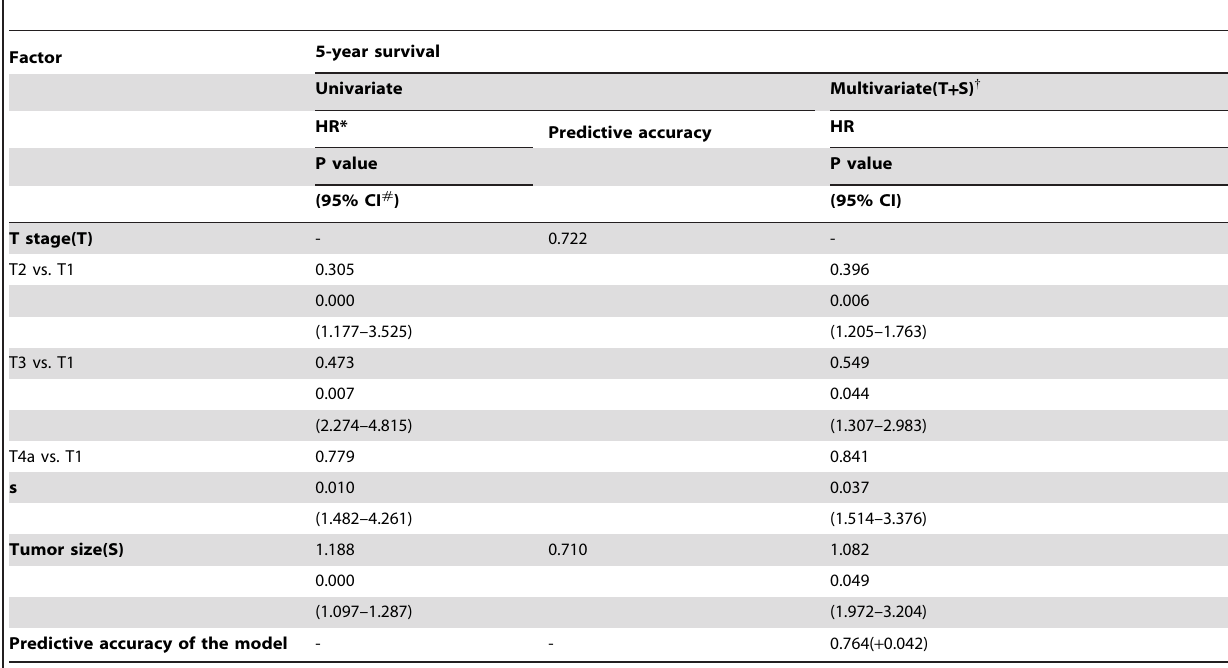
Table 3. Univariate and multivariate Cox regression models predicting depth of invasion, tumor size and 5-year survival in patients with gastric